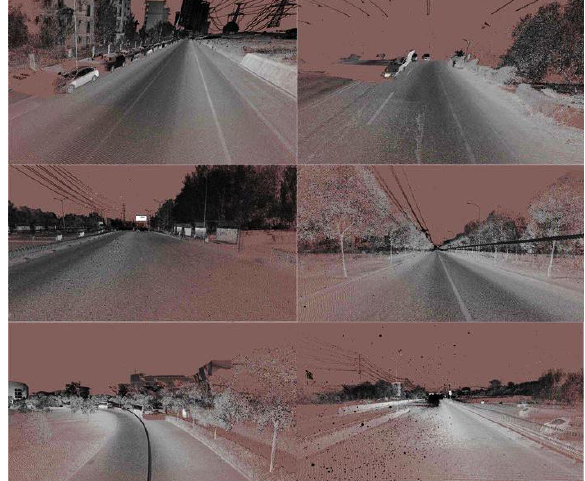
Figure 8. LiDAR data of various road edges